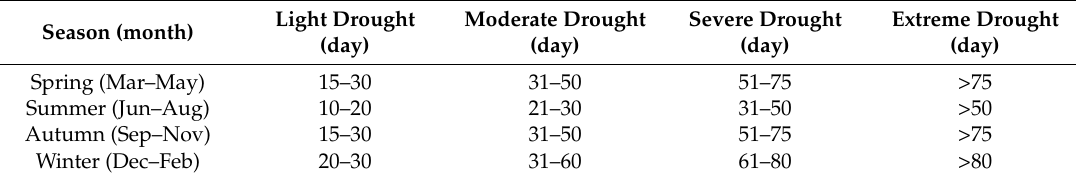
Table 2. Drought magnitude standards of consecutive dry days.